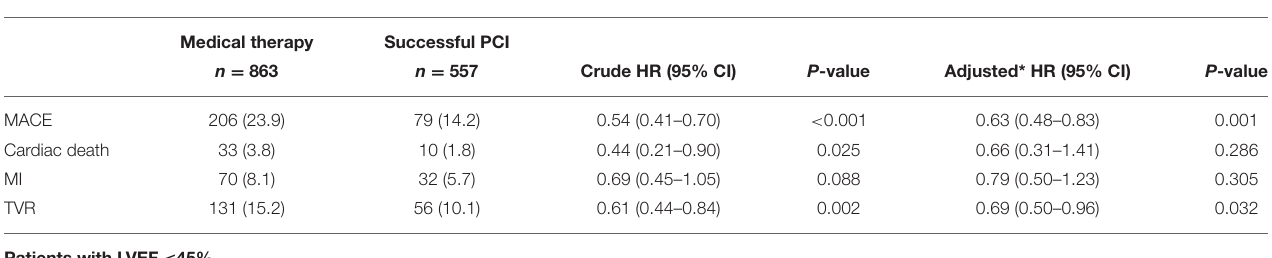
TABLE 4 | Clinical outcomes of patients with LVEF > 45% and with LVEF ≤ 45% stratified according to management. Patients with LVEF > 45%